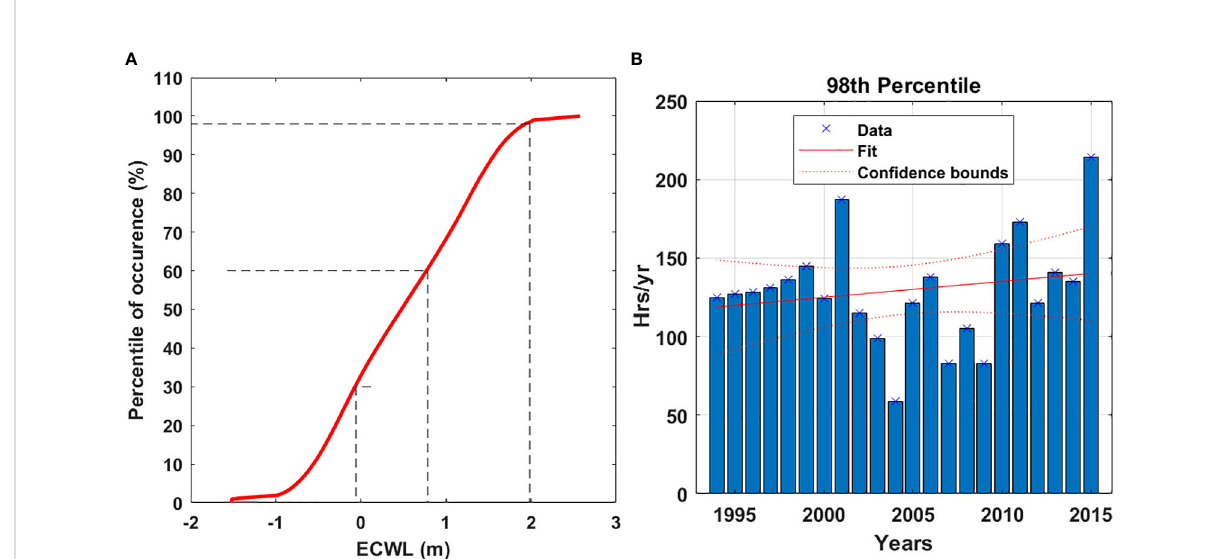
FIGURE 2 (A) Distribution of different percentiles of extreme coastal water level (ECWL), from 1994 to 2015. (B) Number of hours per year that coastal sea level at Saint-Louis reaches the 98th percentile (1.98